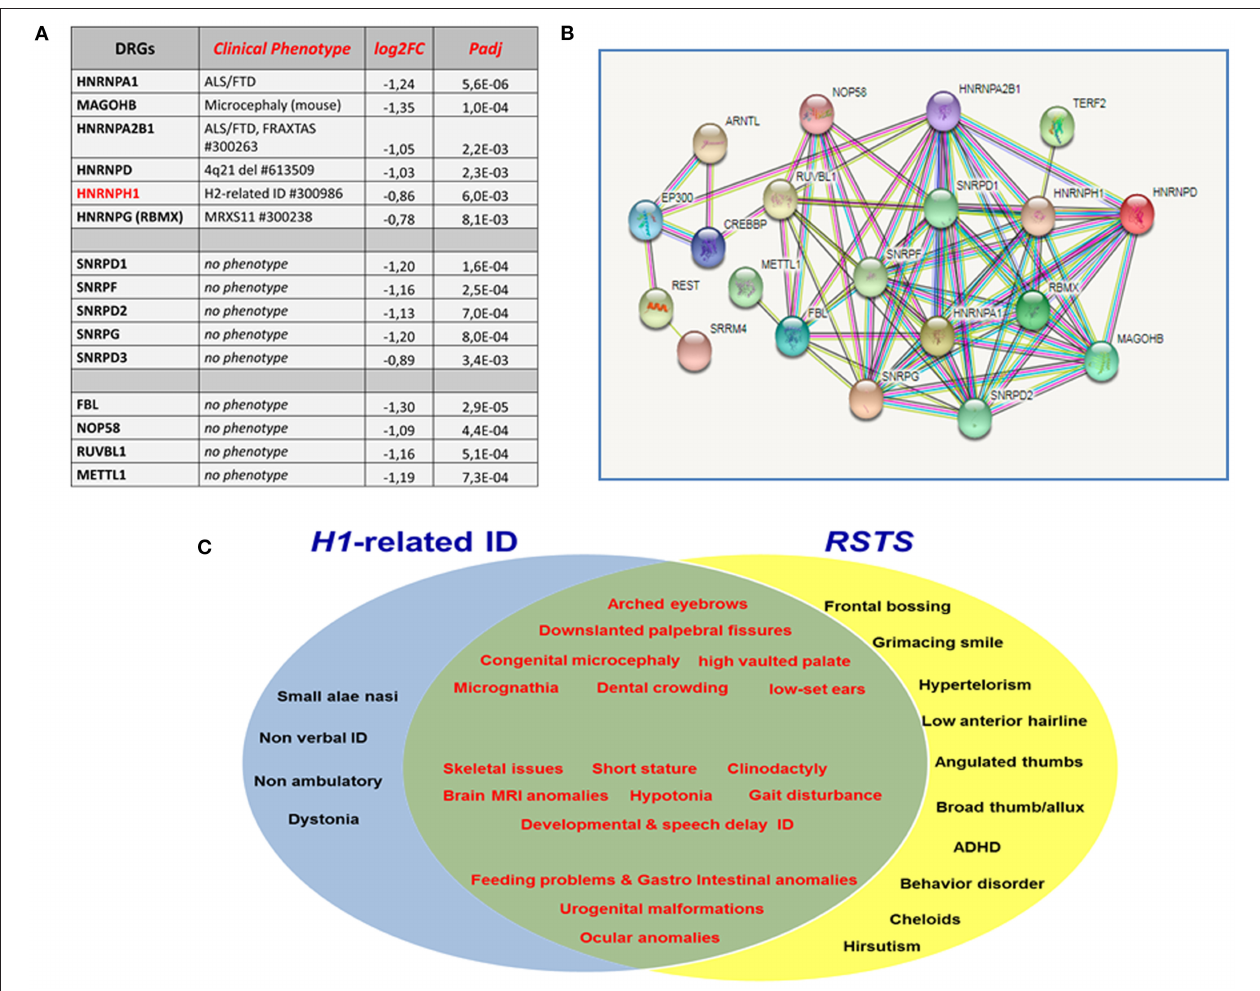
FIGURE 1 | (A) Main groups of downregulated genes (DRGs) in RSTS iNeurons all encoding RNA-binding proteins (RBPs). A prominent set of DRGs encode heterogeneous nuclear ribonucleoproteins (hnRNP) family members, which are involved in all steps of RNA processing: their mutation/downregulation leads to the indicated neurological/neurodevelopmental disorders. Another set of DRGs encode five of the seven core proteins shared by the small nuclear ribonucleoproteins (snRNPs) of the pre-mRNA splicing machinery and also acting in pre-ribosomal RNA processing. Other DRGs encode key nucleolar/ribosomal proteins which defect leads to impaired ribosome biogenesis and disruption of the mutual interactions between RNA processing and chromatin regulation. Fold change levels (Log2FoldChange) and statistical significance values adjusted for multiple comparison (padj-False Discovery Rate) are provided for each gene. To identify differentially expressed genes [DRGs as well as URGs (upregulated genes)], a paired differential gene expression (DGE) analysis (using patients/controls as covariate) was conducted by using DESeq2 package (Love et al., 2014) in R environment, comparing the expression profile of mature neurons with neural progenitors of patients and controls, separately (iNeurons vs. neural progenitors). Genes with a padj < 0.01 [Benjamini–Hochberg (false discovery rate)] were considered differentially expressed (DEGs). RSTS- and control-specific signatures were highlighted by combining/crossing RSTS and controls DEGs lists. (B) The multiple interactions between CBP/p300 and RNA-binding proteins in STRING database (https://string-db.org/) account for the DRGs pointed out by transcriptome analysis of CREBBP/EP300 defective neurons and the consequent perturbed cross-talk between chromatin regulators and RBPs. (C) Venn diagram showing the clinical overlap of HNRNPH1 -related and Rubinstein–Taybi syndrome